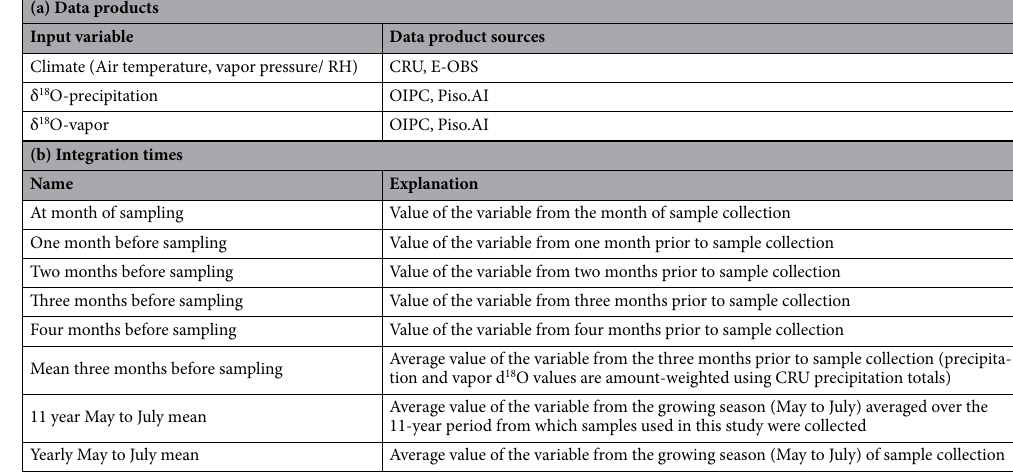
Table 2. (a) Table showing the different climatic (air temperature and vapor pressure) and isotope (precipitation and vapor δ 18 O) data products, (b) as well as the different integration times and names used in the study used to simulate strawberry bulk dried tissue δ 18 O